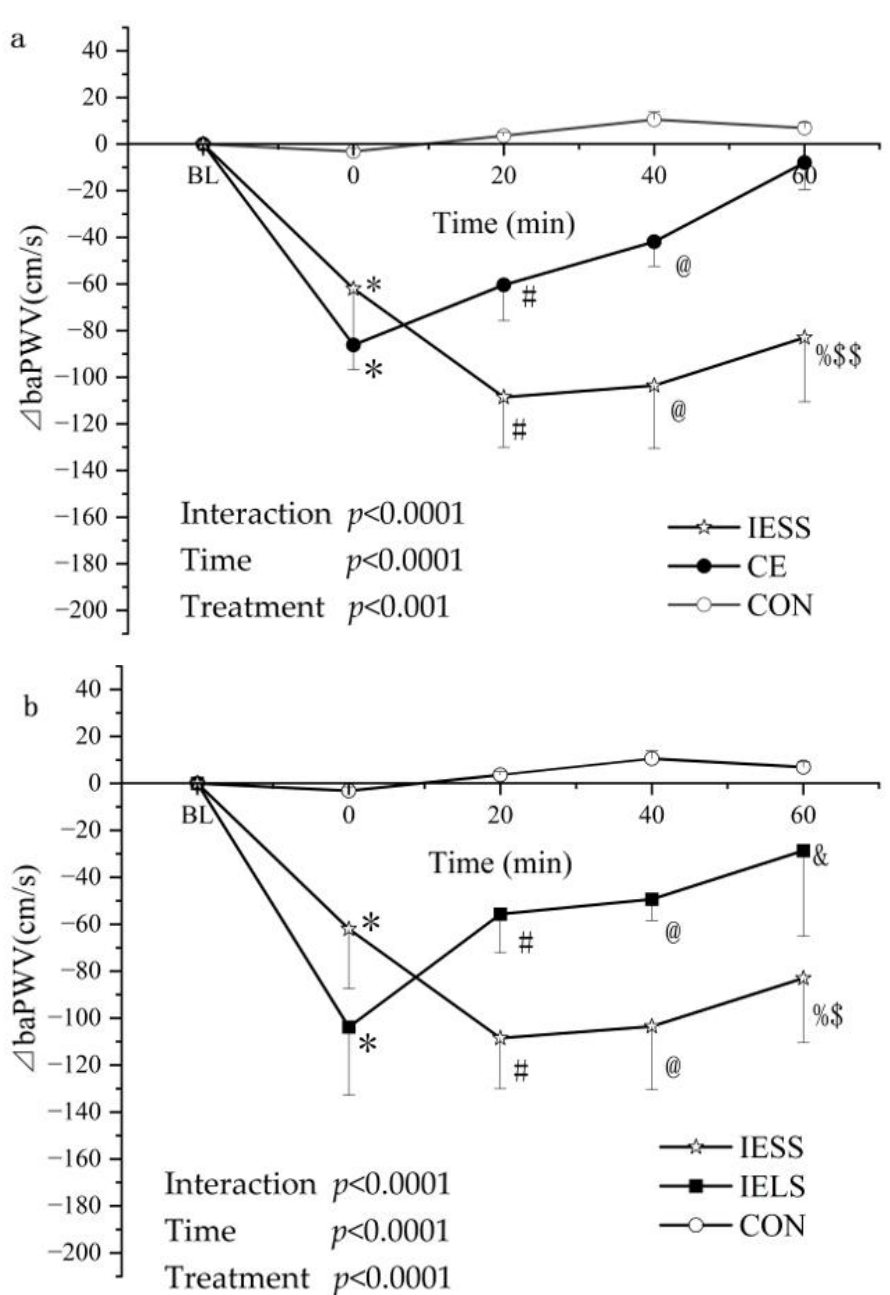
Figure 3. Exercise-induced arterial stiffness time courses with various sessions and brief intersessions. The mean ( ±